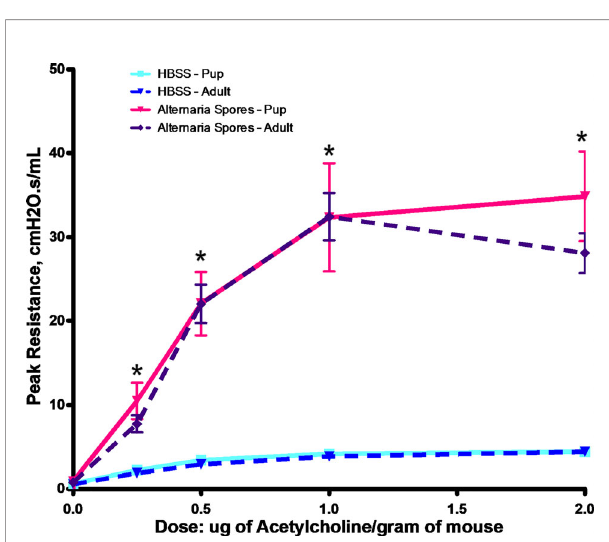
FIGURE 4 | Alternaria spore-induced AHR in adults or neonates. Adult mice or neonates were exposed to spores or HBSS controls. Peak resistance after methacholine challenge was presented as Mean ± SEM, n = 8/group. *P <